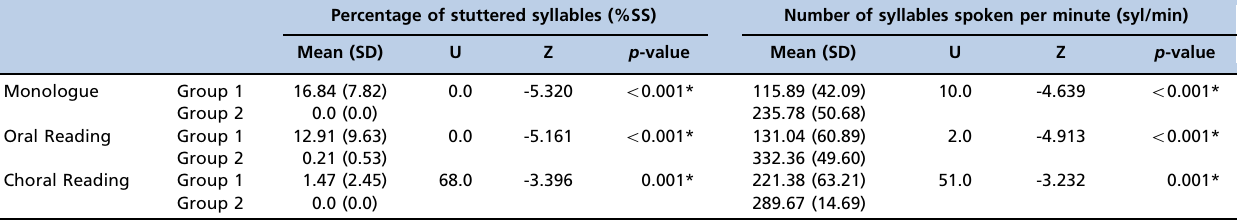
Table 3 - Between group comparisons of speech fluency characteristics.